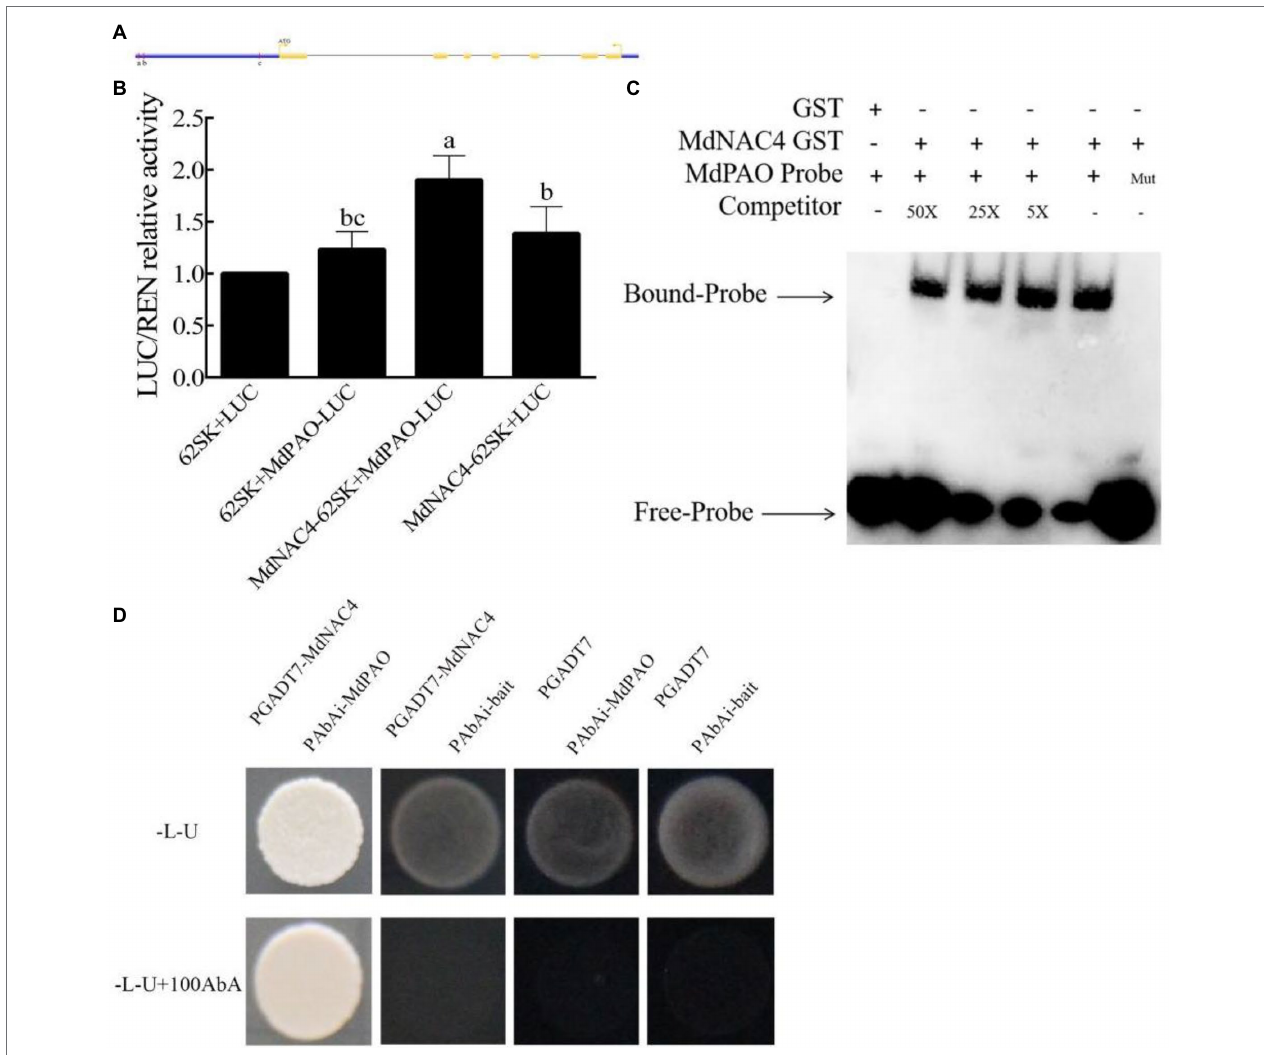
FIGURE 4 | MdNAC4 activated the expression of MdPAO . (A) Diagram of the MdPAO gene promoter region. a-c, represent the potential sites to which MdNAC4 might bind. (B) Transient expression assay of tobacco leaves showing that MdNAC4 activated the expression of MdPAO . (C) EMSA showing that the MdNAC4-GST fusion protein was bound to the MdPAO promoter. Unlabeled probes were used as competitors, with “Mut” representing the mutated probe in which the 5’-ACGTG-3 ′ motif was replaced by 5’-CCGTC-3 ′ . (D) Y1H assay revealing the interaction between MdNAC4 and the MdPAO promoter. The data are expressed as the means ± SDs ( n = 3). The significance of the differences was tested by one-way ANOVA; p <